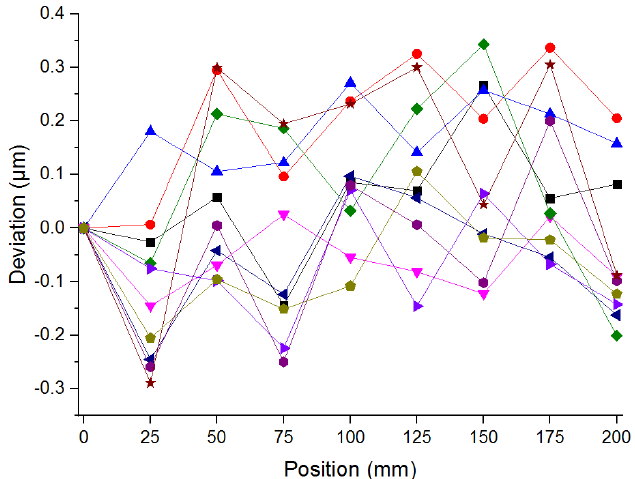
Figure 10. Comparison result of linear displacement.